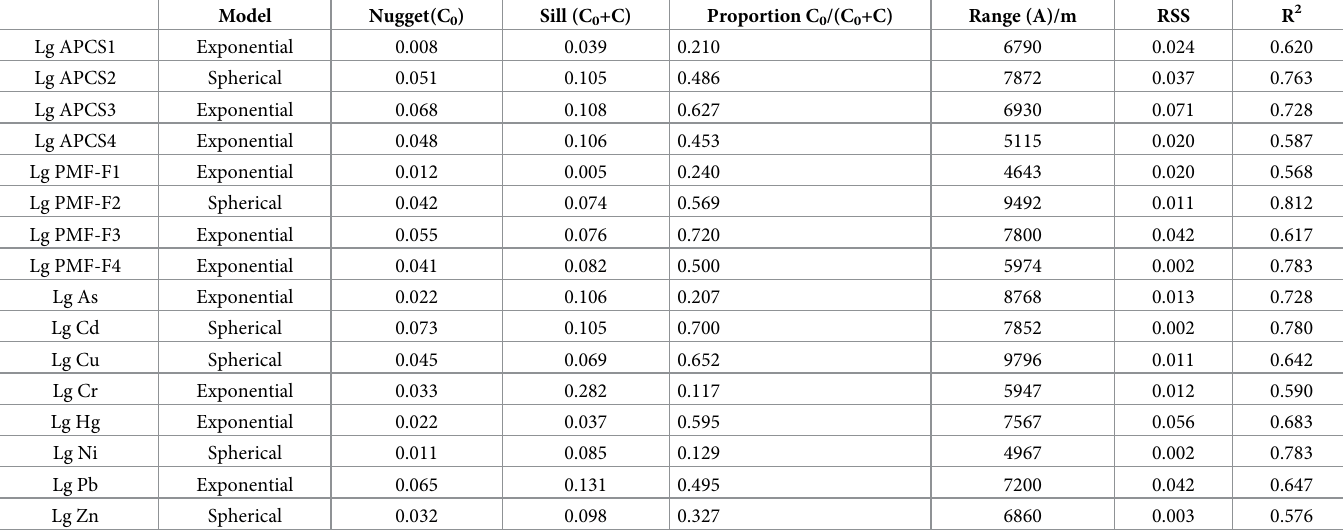
Table 4. Optimal variation function model of the source factors and soil potentially toxic